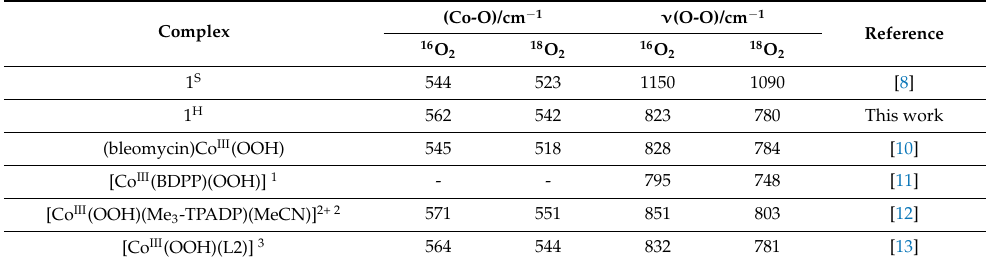
Table 1. ν (Co-O) and ν (O-O) data of 1 S , 1 H , and reported cobalt(III)-hydroperoxido species.